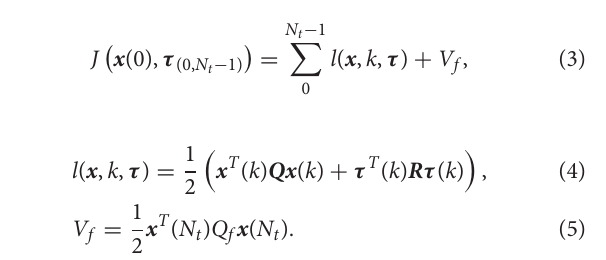
FIGURE 1 | Structure of the three-joint and five-link model. m 4 , m 3 , m 2 , m 1 , and m 0 represent the masses of the left arm, right arm, upper body, lower body, and foot, respectively. L 4 , L 3 , L 2 , L 1 , and L 0 represent the lengths of the left arm, right arm, upper body, lower body, and foot, respectively. q 3 , q 2 , and q 1 represent the left-right arm angle, hip angle, and ankle angle, respectively. Here, the right arm and left arm share the same joint motor.